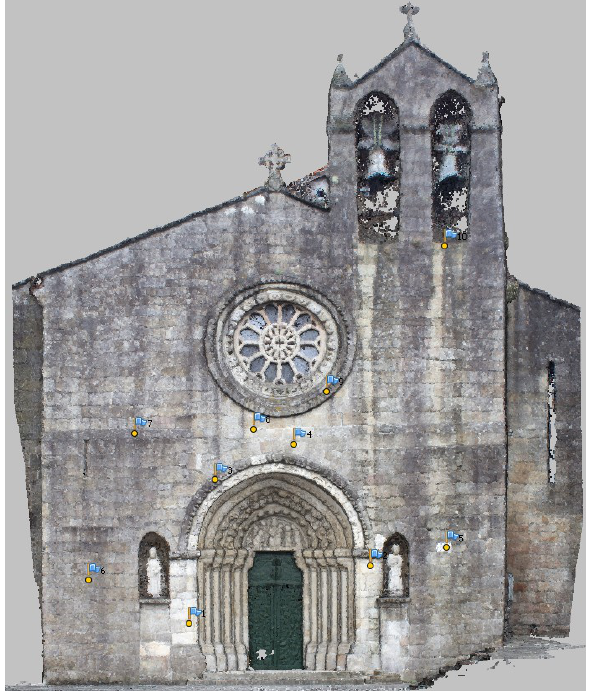
Figure 10. Orthoimage of the Dense Point Cloud of the whole project (2,423,632 points) and the GRP and GCP on it.